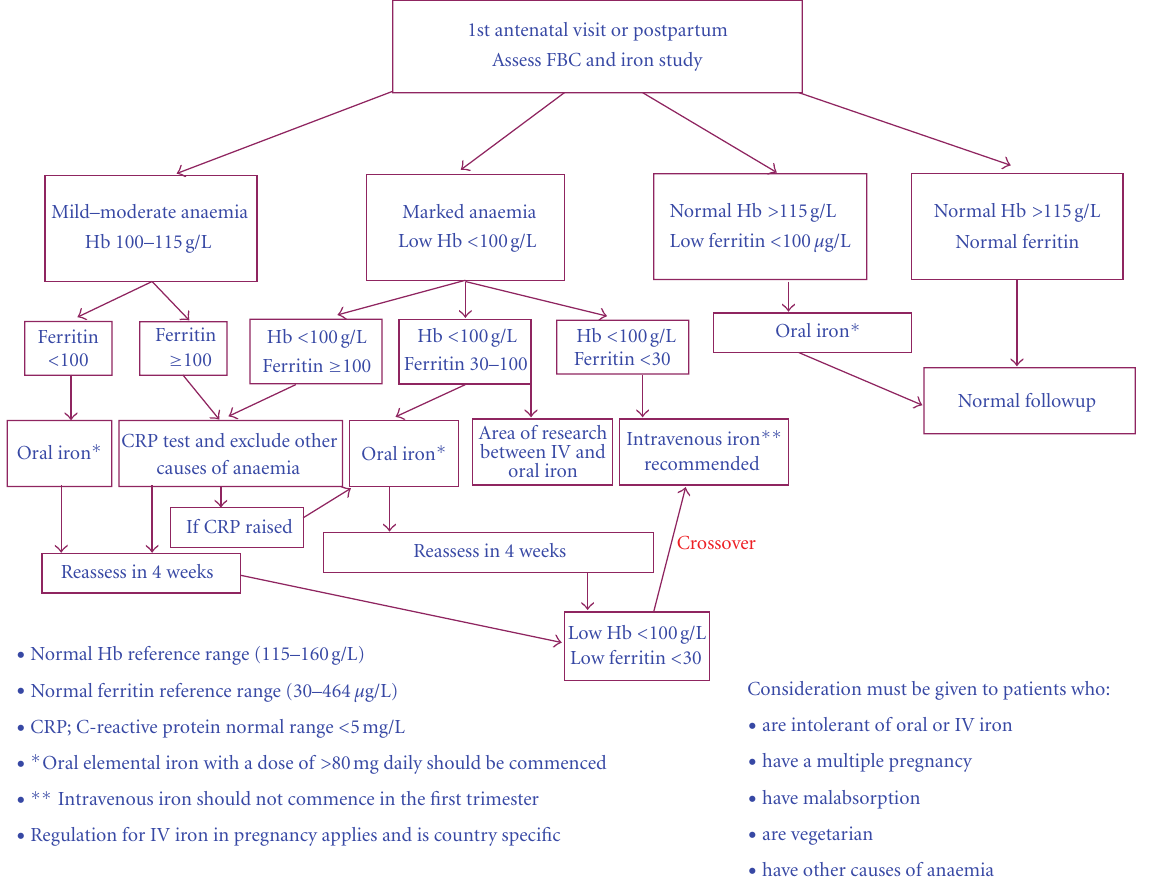
Figure 1: Proposed treatment for anaemia in pregnancy and postpartum period based on di ff erent randomized and non-randomized